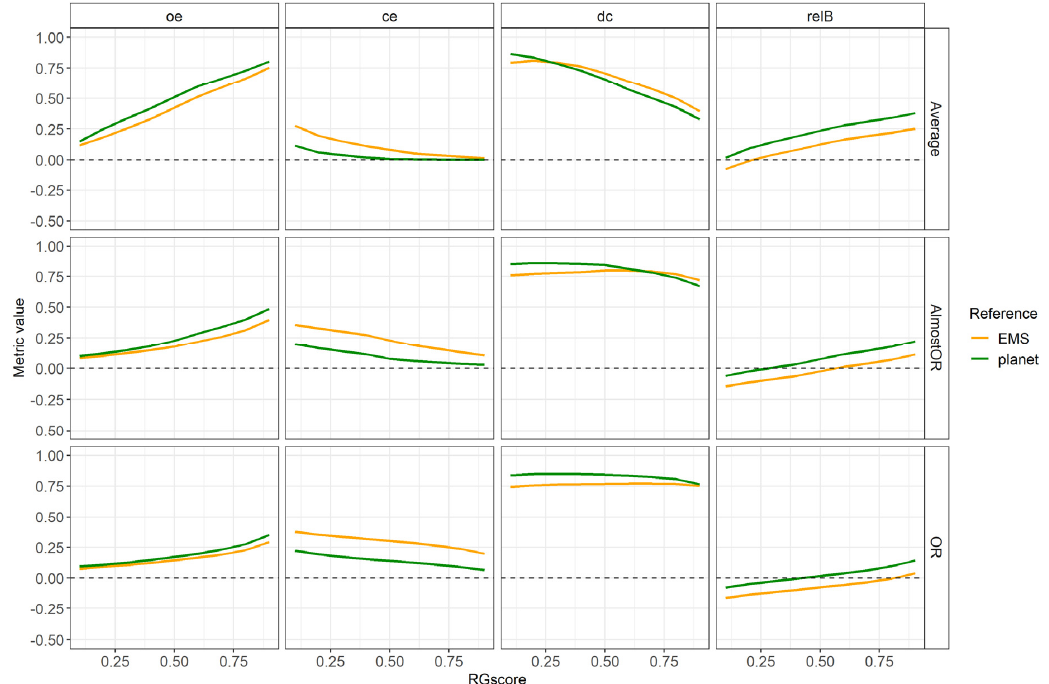
Figure A1. Estimates of the accuracy metrics omission error (oe), commission error (ce), Dice coefficient (dc) and relative bias (relB) over the Vesuvius site estimated by comparison with PlanetScope (green lines) and EMS (orange line) fire reference polygons, horizontal red dashed line shows y = 0.